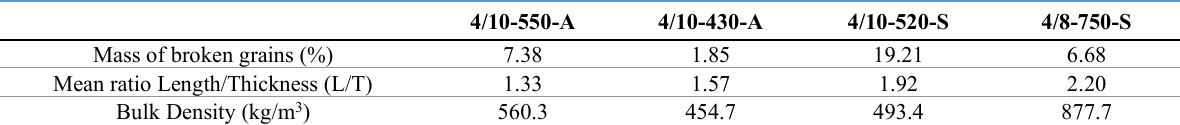
Table 1 P hysical and geometrical properties of aggregates